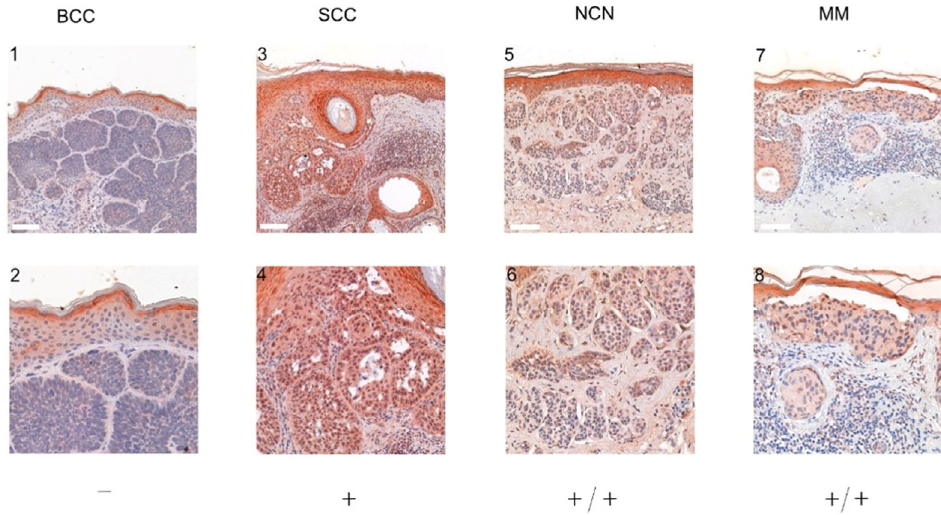
Figure 2. Representative immunohistochemical staining for TRPC4 in BCC, SCC, NCN and MM tissue. The tumor cells of BCC (example shown in 1 – 2 : patient 9 = slide number A1M_11S_1, see